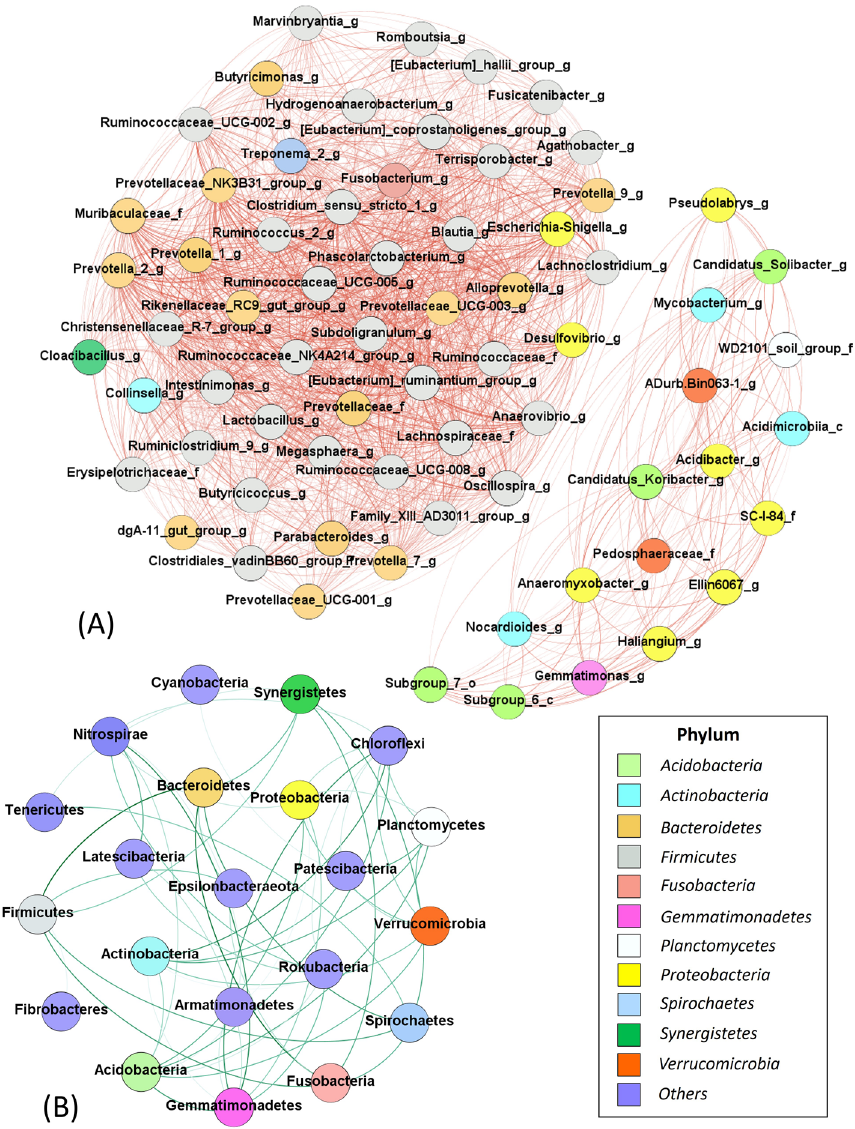
Figure 6. Bacterial community networks at genus ( A ) and phylum ( B ) levels among all samples. Unclassified genera are appended with _f, _o, _c, _p to refer to known family, order, class and phylum, respectively. Co-occurrence nodes and connections were calculated based on Spearman’s correlation using ρ ≥ 0.6 and false discovery rate adjusted p -value < 0.01). Thick lines highlight a strong connection. Each bacterial phylum is represented using different colours in the rectangular